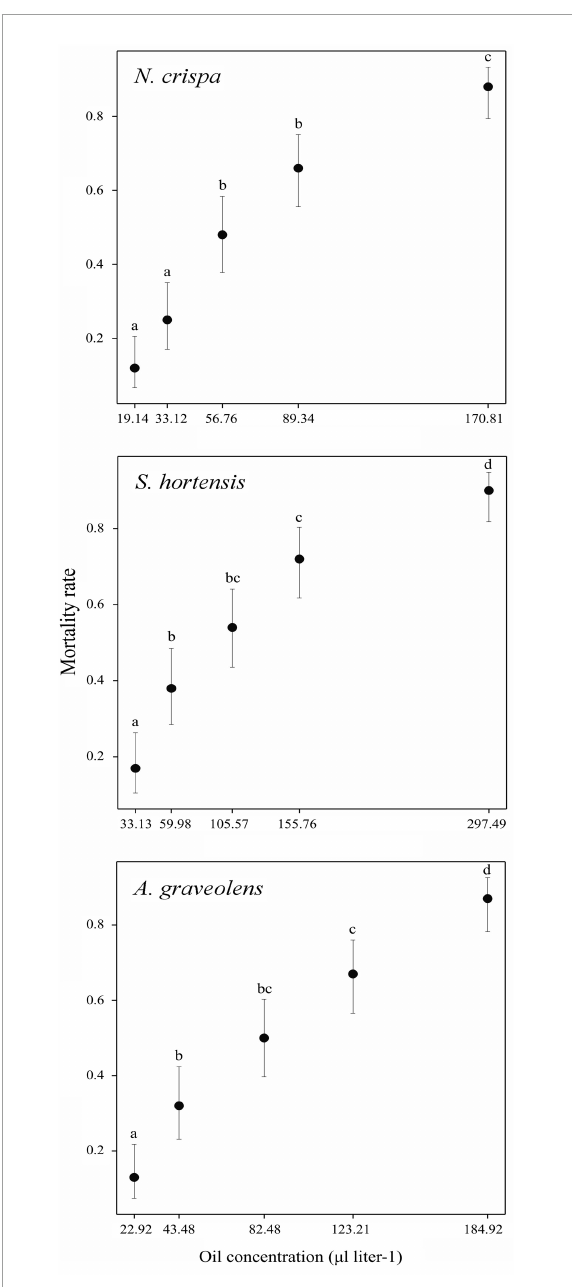
FIGURE1 Estimated mean mortality of Tetranychus urticae adults by residual concentrations of Nepeta crispa , Satureja hortensis , and Anethum graveolens . The circles are the back-transformed predicted means by the GLM model and the vertical lines show back-transformed 95% CIs estimated by the generalized linear model. Means sharing a letter do not differ significantly ( P <